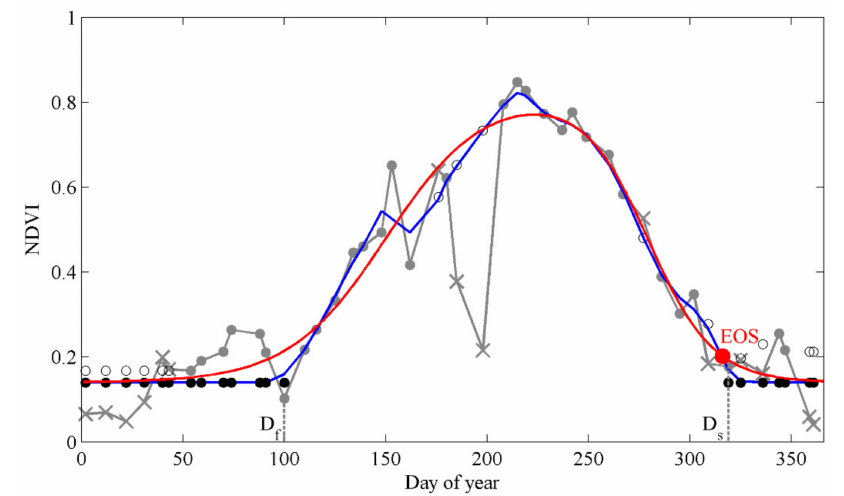
Figure 2. Schematic diagram for determining the end of the growing season taking the Normalized Di ff erence Vegetation Index (NDVI) as an example. The grey line denotes the raw NDVI time series. The grey dots and crosses represent normal and snow / ice / cloud-contaminated abnormal NDVI values, respectively. The circles are the interpolated vegetation index (VI) values that replaced the abnormal values. D f and D s are the dates when the minimum VI (maximum Plant Senescence Reflectance Index (PSRI)) occurred in the first half of the reconstructed VI sequence and in the second half of the reconstructed VI sequence, respectively. The black dots denote the replaced VI values from 1 January to D f and from D s to 31 December. The blue line denotes the smoothed NDVI time series using the five point moving average. The red line is the fitted double logistic